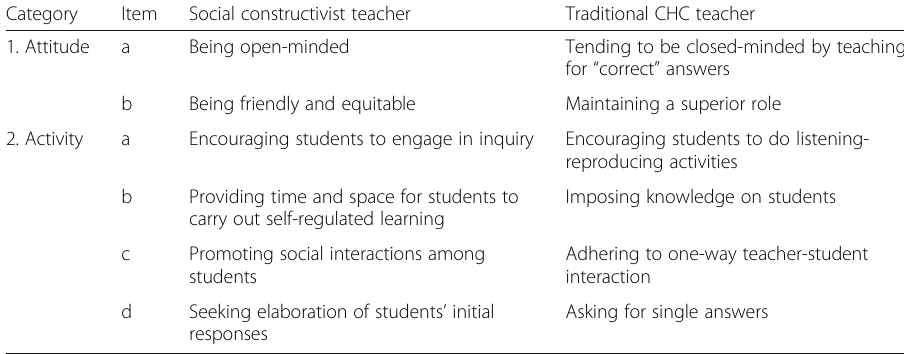
Table 1 Basic characteristics of a social constructivist teacher and of a traditional CHC teacher Category